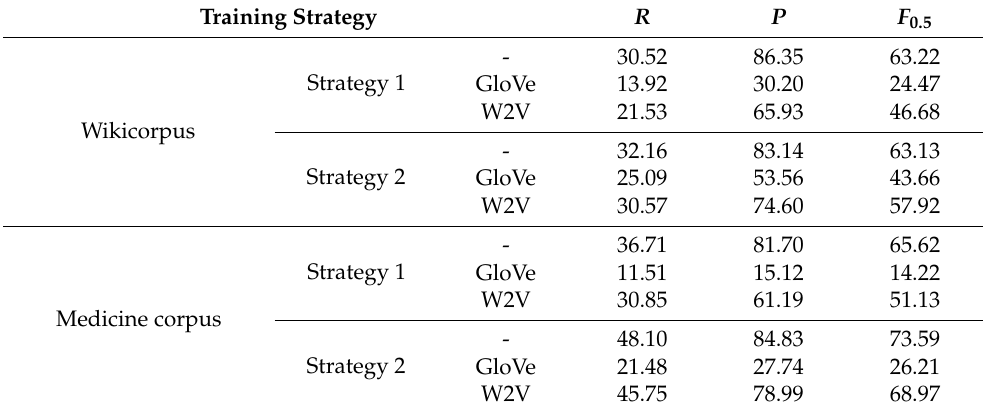
2. Evaluation of number error correction . Table 10 shows the performance of the models on number error types. In the Wikicorpus, the model without pretrained embedding corrected 43.01% of errors in the training set generated using strategy 1, whereas it corrected 49.58% in the training set generated using strategy 2. Precision is high for both: 87.81% and 84.18%, respectively. GloVe results were much lower in the training set generated using strategy 1 ( R = 27.12% and P = 45.53%) and the training set generated using strategy 2 ( R = 39.45% and P = 62.66%), whereas Word2Vec performed similar to the model without pretrained embedding ( R = 48.93% and P = 81.42%) in the training set generated using strategy 2. In the medicine corpus, models without pretrained embedding and models with Word2Vec improved when trained on medicine sentences. The model without pretrained embedding shows F 0.5 = 77.22% in the training set generated using strategy 1 and F 0.5 = 82.82% in the training set generated using strategy 2. This last model corrected more than 70% of sentences. For both corpora, better results were obtained in the training set generated using strategy 2 than in the training set generated using strategy 1. Table 10. Recall ( R ), precision ( P ) and F 0.5 for the evaluation of number error correction. Training Strategy